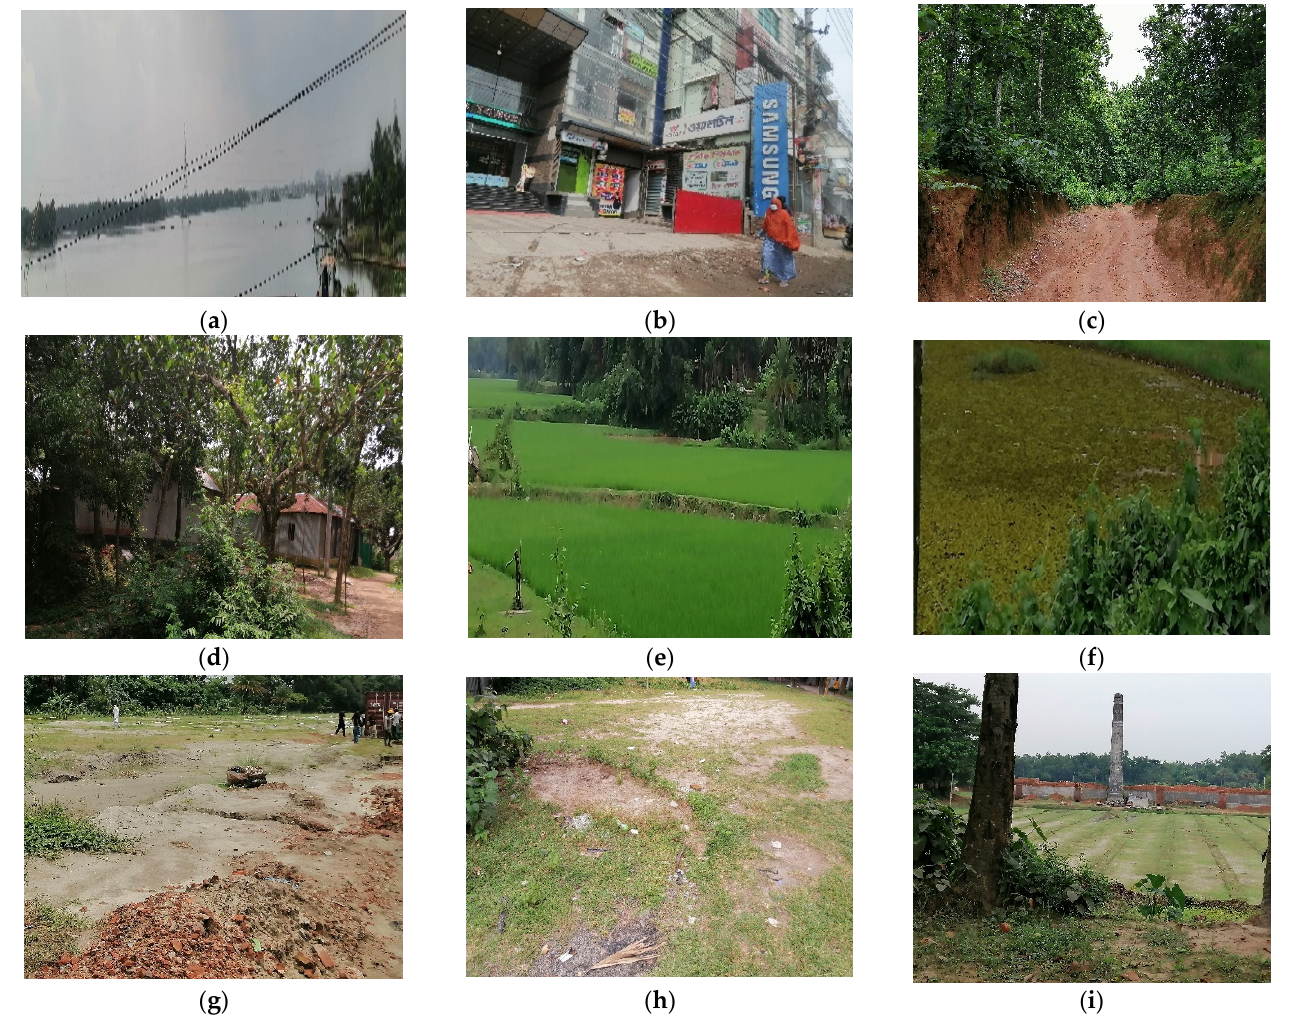
Figure 2. Different land classes ( a – i ). ( a ) Water; ( b ) Built-up; ( c ) Vegetation (Forest); ( d ) Vegetation (HFS); ( e ) Agriculture; ( f ) Low land; ( g ) Fallow land (Sand filled); ( h ) Fallow land (Barren); ( i ) Fallow land (Brick field).